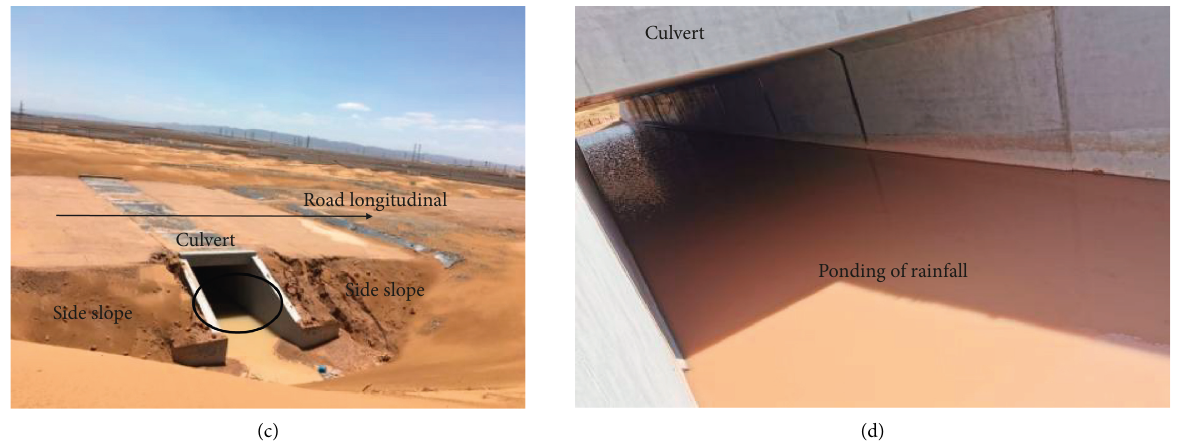
Figure 9: Site water damage of slope at box culvert. (a) The deformation field. (b) Seepage field. (c) Slope erosion. (d) Box culvert bottom water.